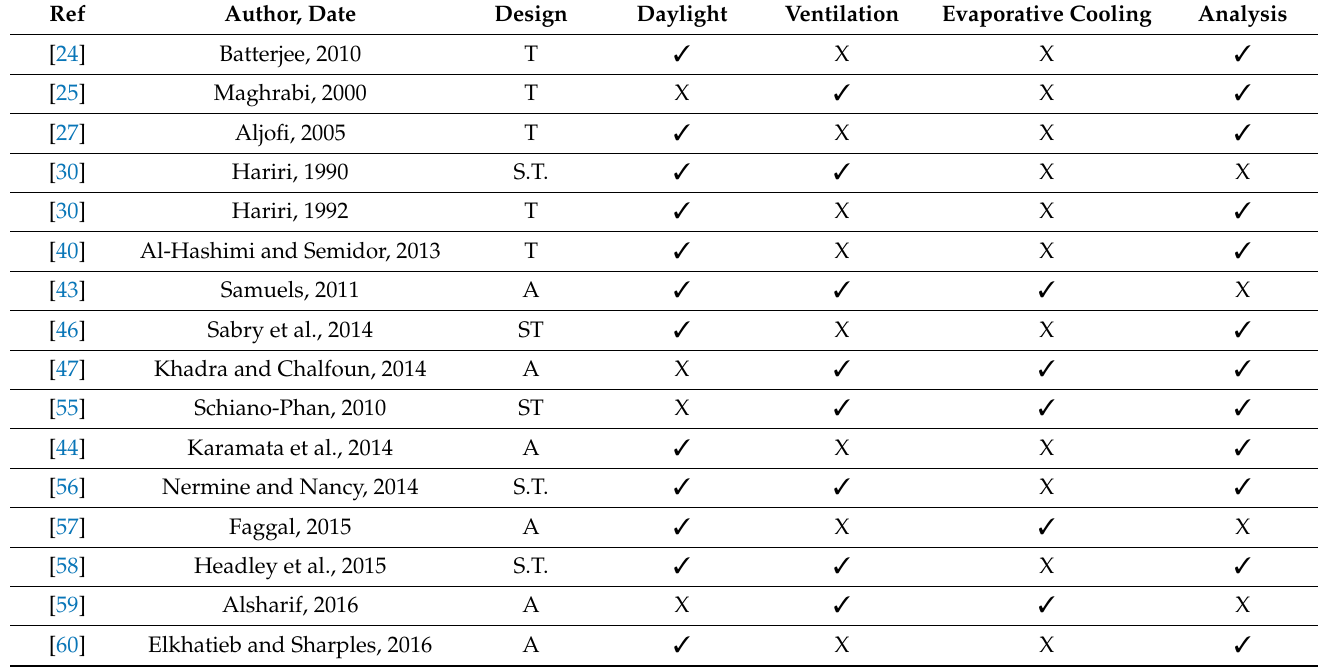
Table 1. Review some primary research on mashrabiyas and different aspects.